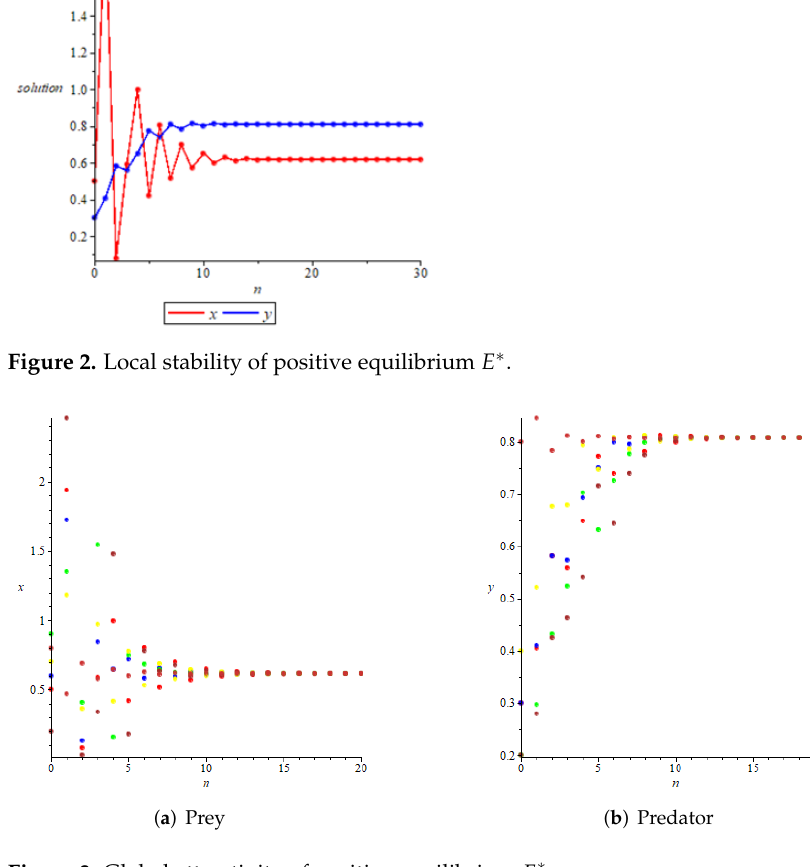
Figure 3. Global attractivity of positive equilibrium E ∗ .